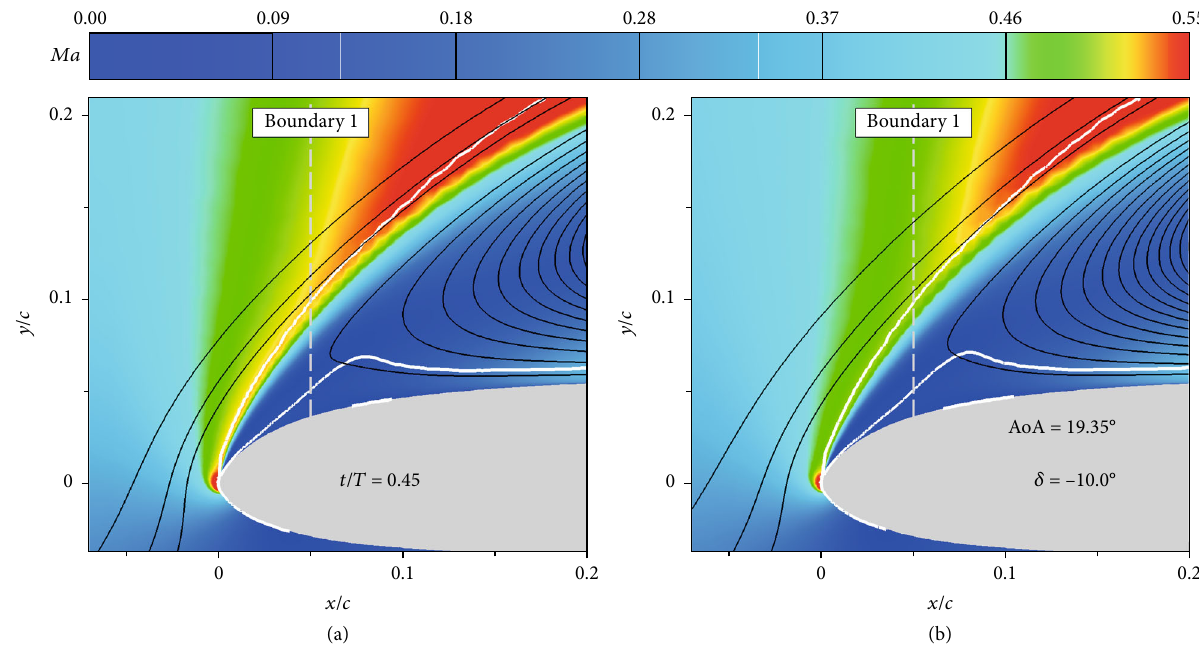
Figure 22: Streamlines and Mach number contours around the leading edge at t / T = 0 : 45 for the two airfoils: (a) original airfoil and (b) TEF airfoil. The solid white line represents the contour line that the normalized vorticity is -10.